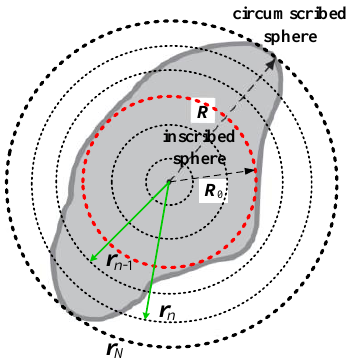
Figure 1. The discretization of the non-spherical particle in the spherical coordinate system.